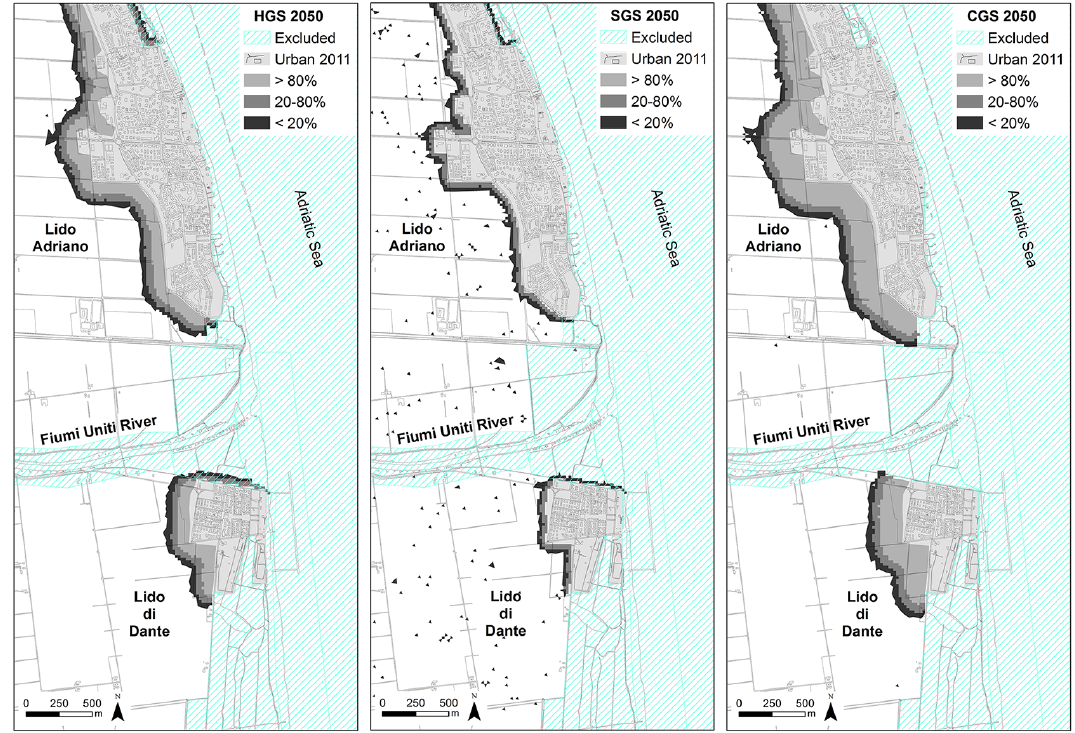
Figure 5. Difference between the HGS, the SGS and the CGS for the year 2050: example of Lido Adriano and Lido di Dante, Ravenna. Table 6. Results of overlay of TWL scenarios with SLEUTH prediction scenarios.